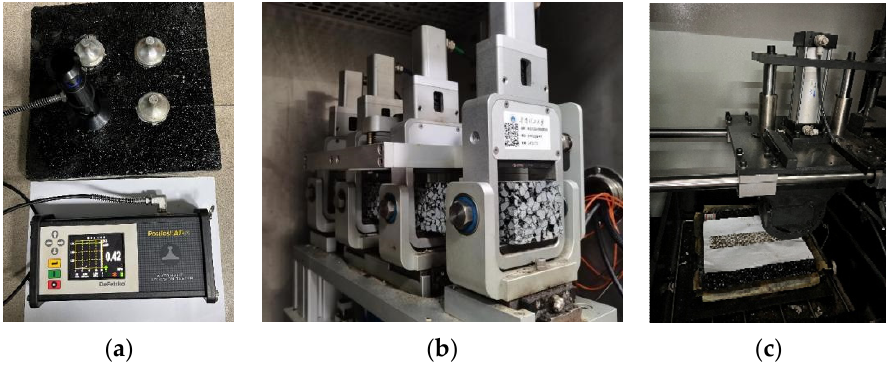
Figure 4. ( a ) Pull strength test; ( b ) four-point beam fatigue test; ( c ) dynamic stability test.